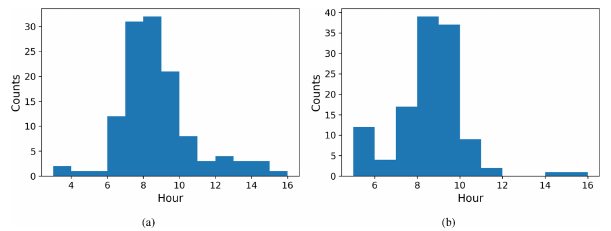
Figure 10. Histograms of start time for (a) NPF events and (b) boundary layer growth. The time axis is local time (hours UTC +